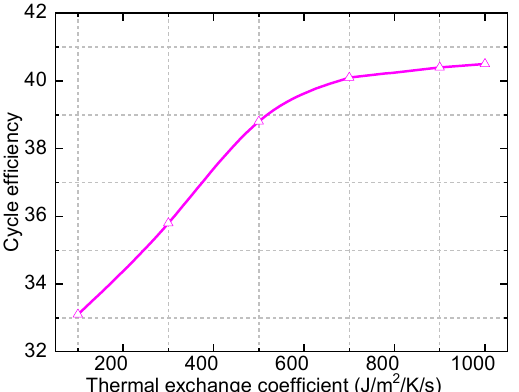
Figure 15. Maximum power of the system.